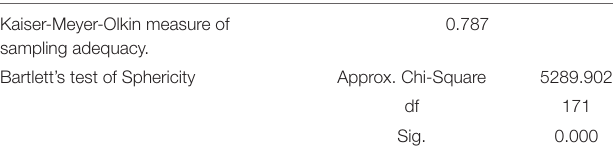
TABLE 4 | KMO and Bartlett’s test. Kaiser-Meyer-Olkin measure of sampling